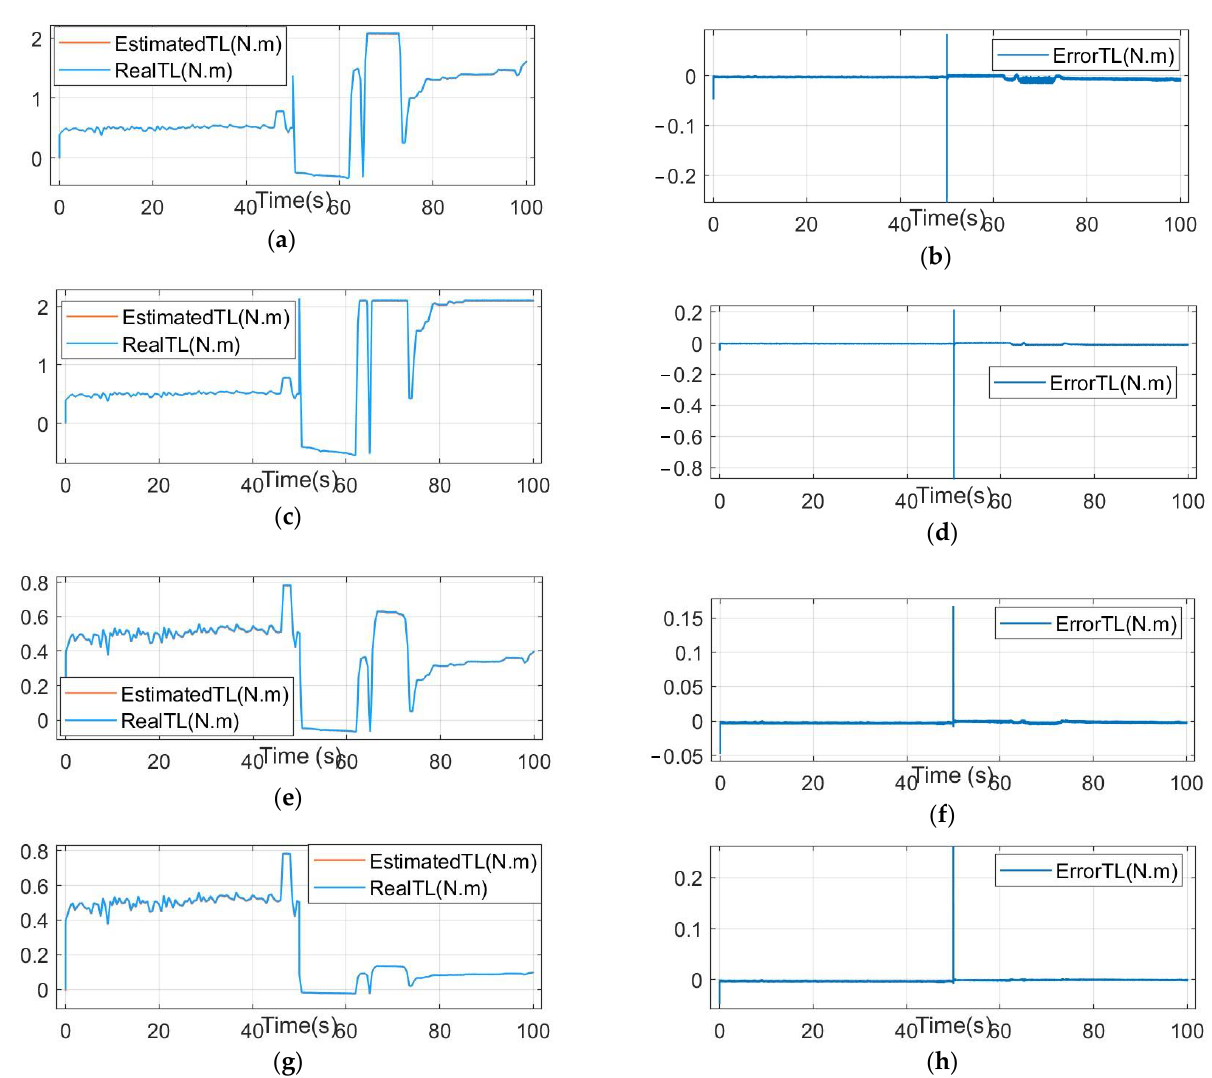
Figure 5. Load torque estimation of the thruster in the fault states: ( a ) torque estimation of a thruster with an entanglement fault; ( b ) torque estimation error of a thruster with an entanglement fault; ( c ) torque estimation of a thruster with a jamming fault; ( d ) torque estimation error of a thruster with a jamming fault; ( e ) torque estimation of a thruster with a breaking fault; ( f ) torque estimation error of a thruster with a breaking fault; ( g ) torque estimation of a thruster with a falling-off fault; ( h ) torque estimation error of a thruster with a falling-off fault.